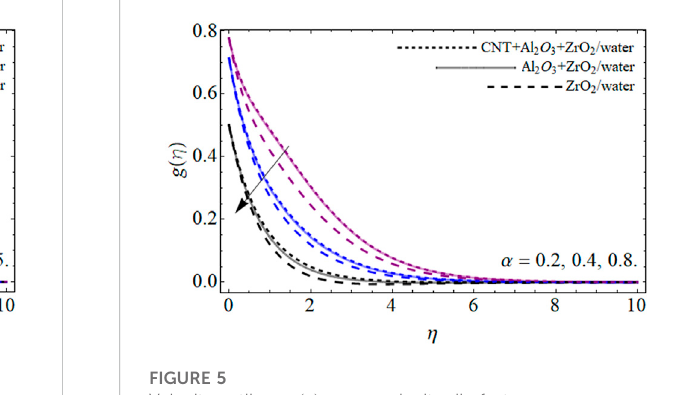
FIGURE 3 Velocity outlines f ′ ( η ) versus magnetic term M .